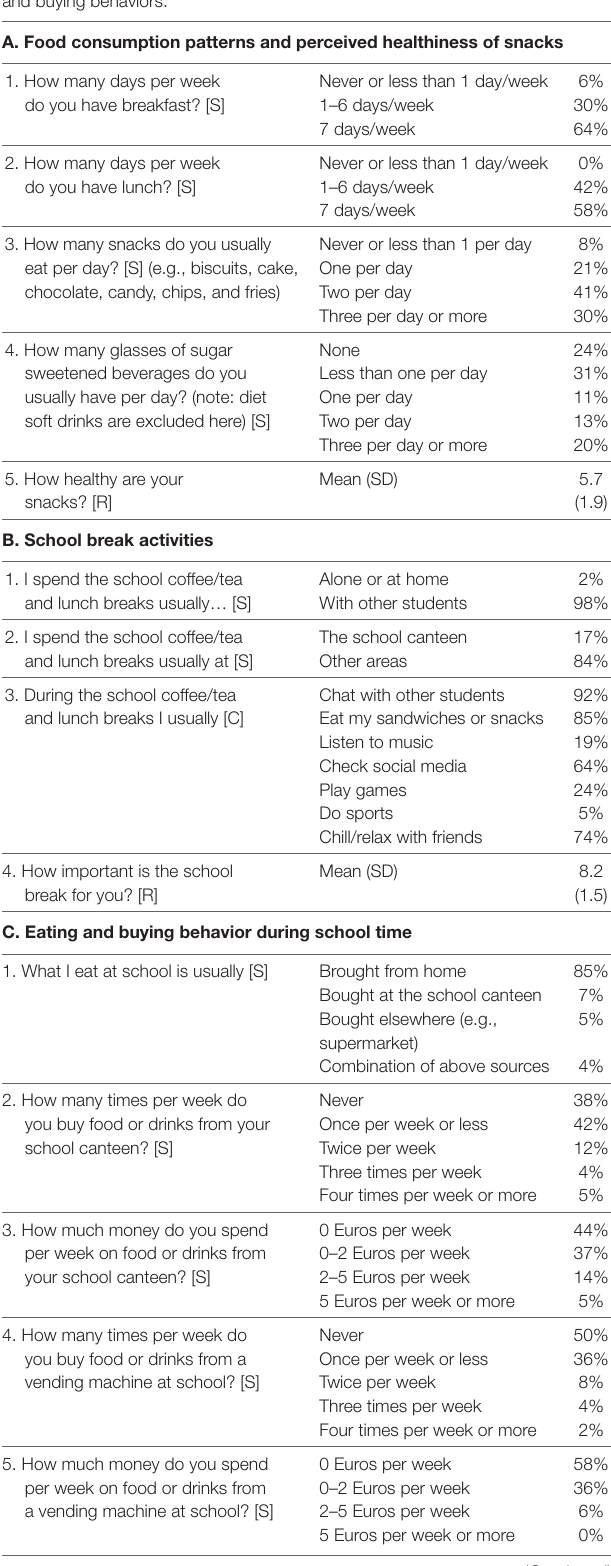
TaBle 2 | Dutch adolescents’ ( N = 133) survey responses related to their eating and buying